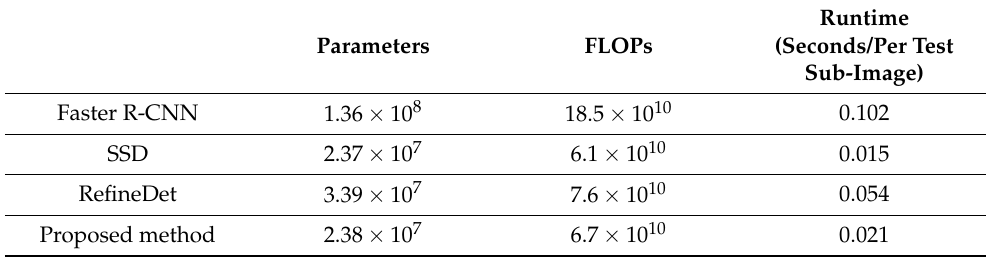
Table 2. Complexities of the proposed method and other deep-learning based